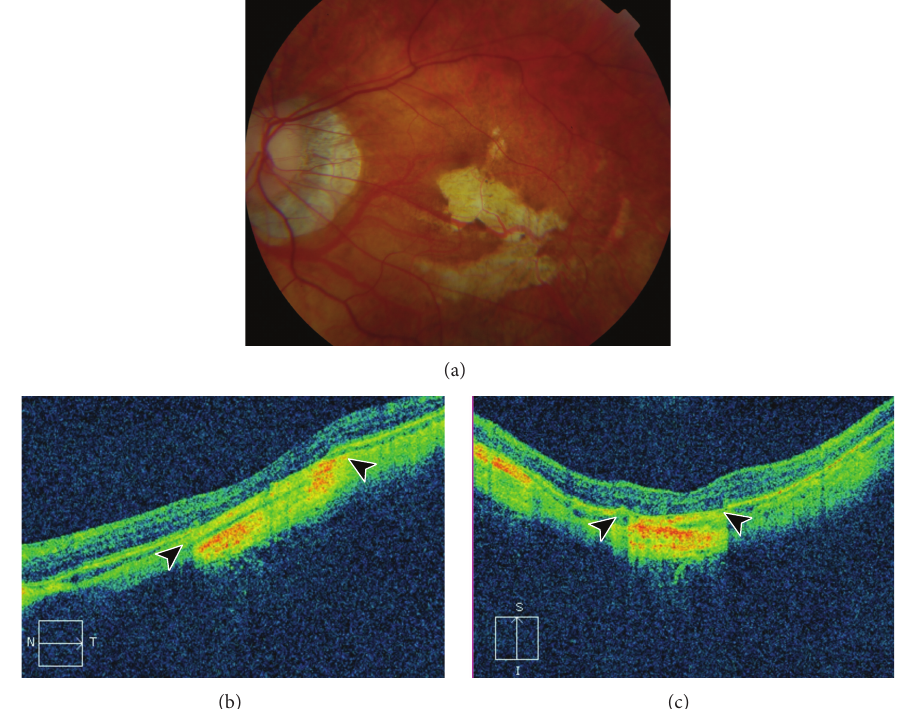
Figure 2: Color retinography and optical coherence tomography after twelve months. (a) Color photography illustrating a tessellated fundus with a yellowish, ill-defined, patchy chorioretinal atrophy in and around the macular area. (b and c) Horizontal and vertical spectral- domain optical coherence tomography showing complete resolution of the myopic foveoschisis and foveal retinal detachment with increased hyperreflectivity in the deep tissue of the sclera due to the atrophy of the superior retinal layers in the macular area (arrows). The outer retina, retinal pigment epithelium, and choroid are not present in the area of the patchy atrophy. The inner retina is directly attached to the sclera (between